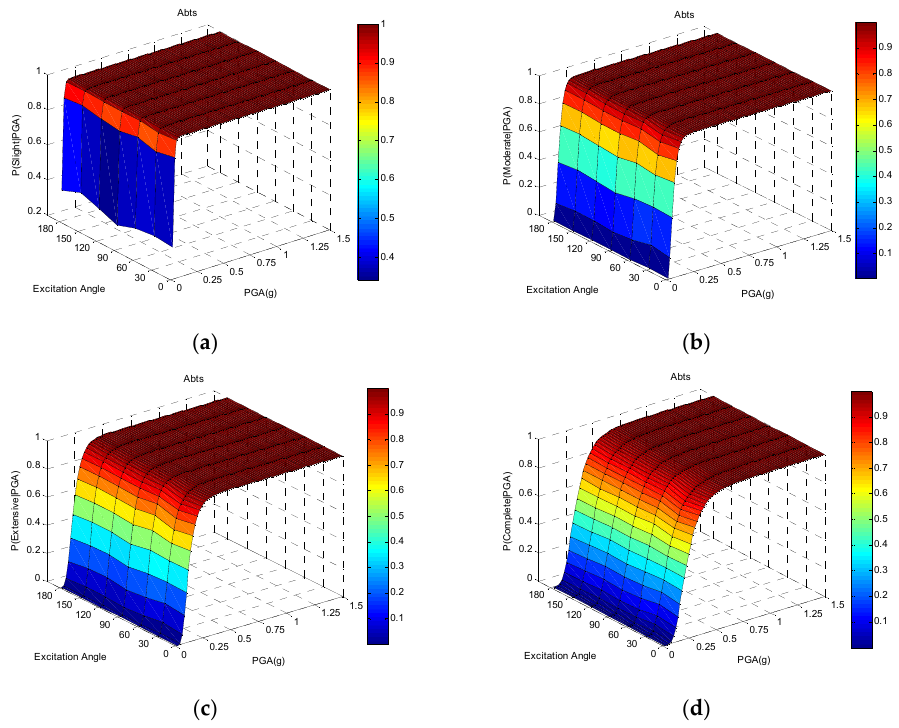
Figure A7. Seismic fragility surfaces of Abts subjected to different excitation angles in the ( a ) slight; ( b ) moderate; ( c ) extensive; and ( d ) complete limit states.